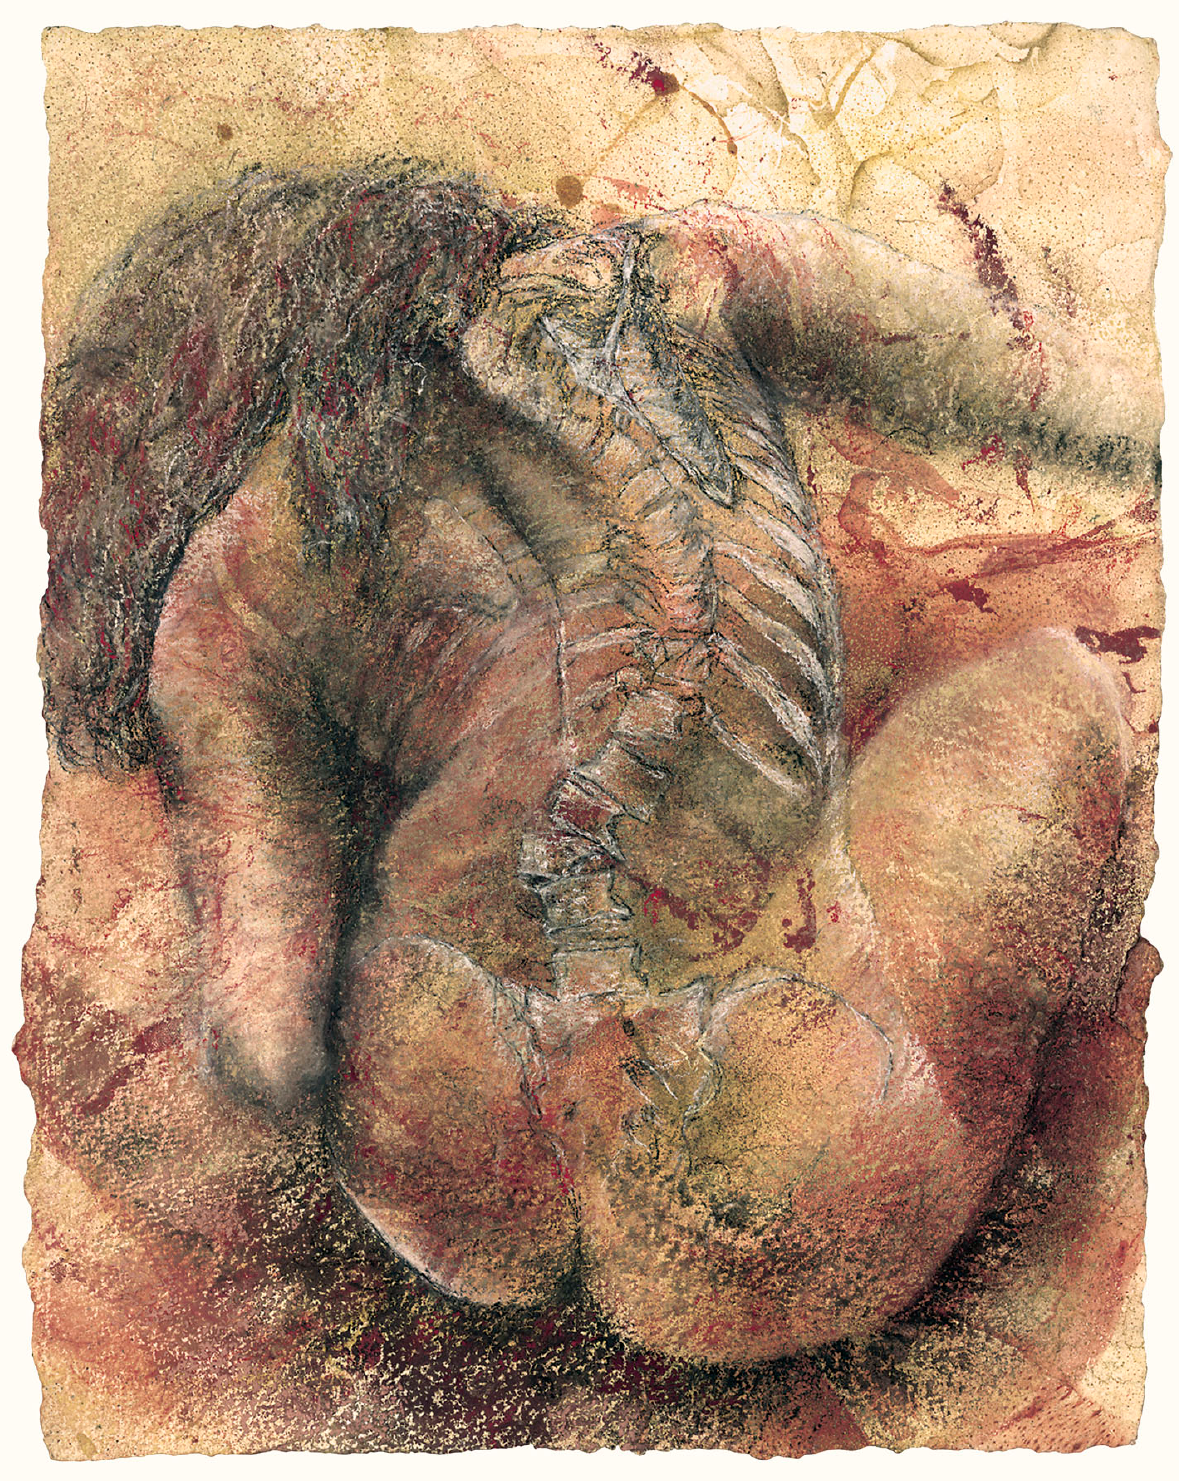
Figure 2 | Laura Ferguson, Crouching figure with visible skeleton, 1996. Courtesy of the